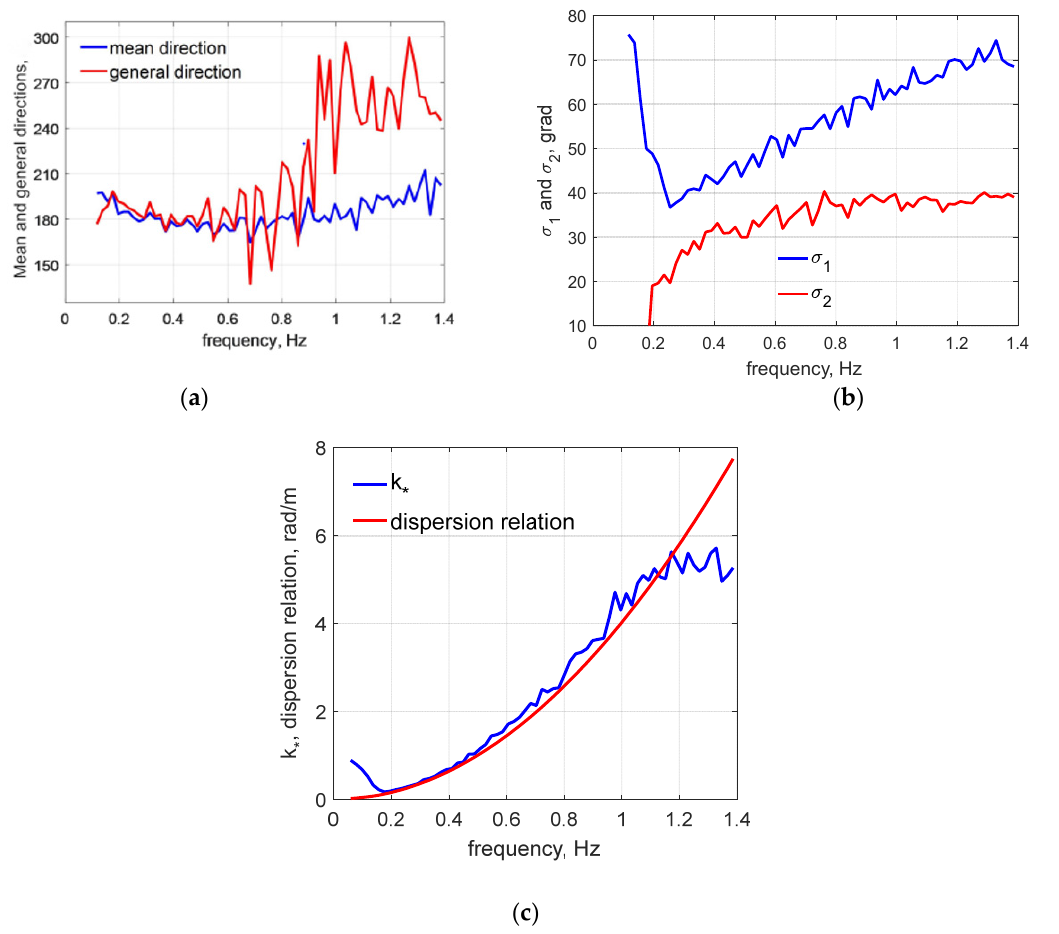
Figure 9. Parameters of the angular distribution of waves: average and general direction of waves ( a ); angular width of the wave spectrum ( b ); dispersion relation ( c )).